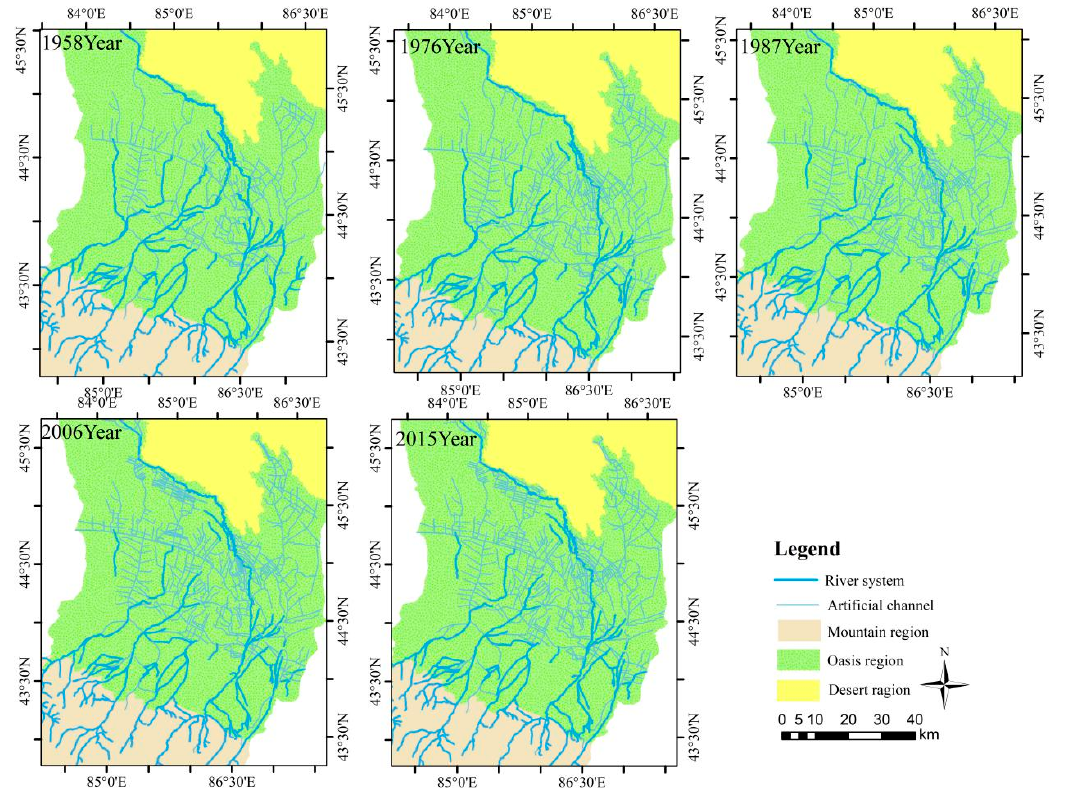
Figure 4. Stream construction of the Manas River Basin from 1958–2015.